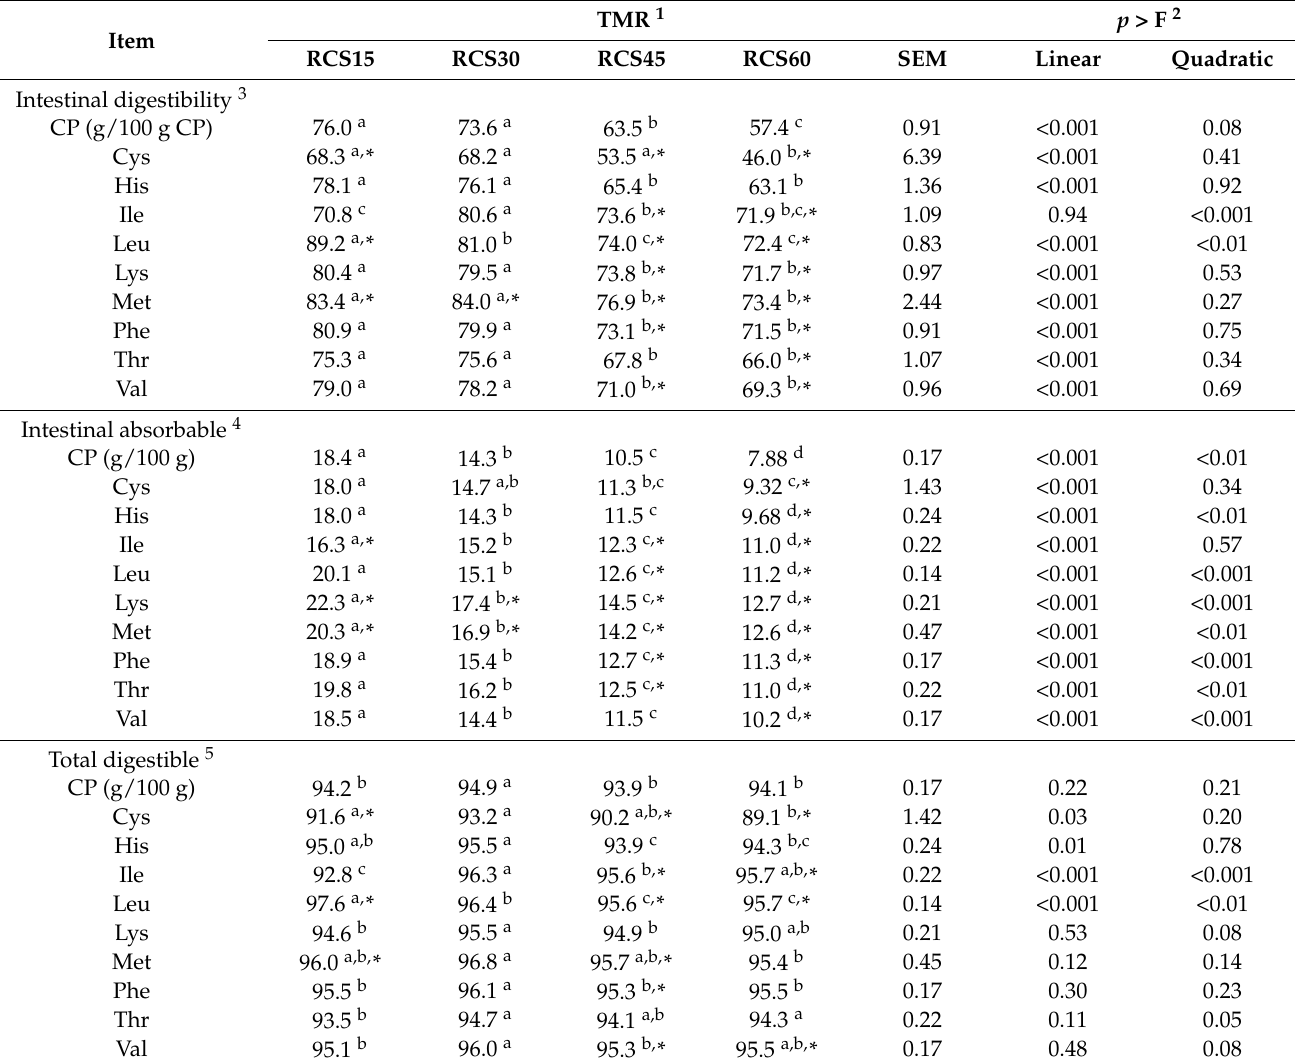
Table 5. Intestinal digestibility of essential amino acids (AAs) of total mixed rations (TMR) containing increasing proportions of red clover